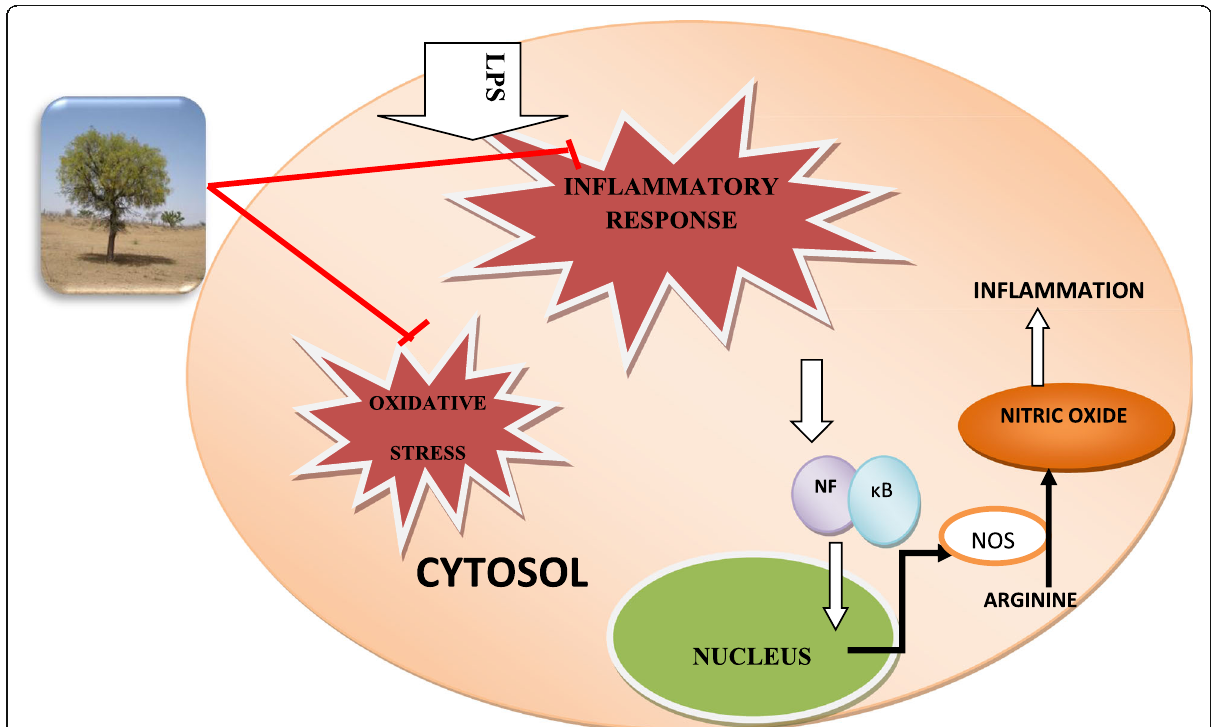
Fig. 5 Diagrammatic Representation of action of Prosopis cineraria against LPS-induced inflammation (imaged by Veena Sharma and Preeti